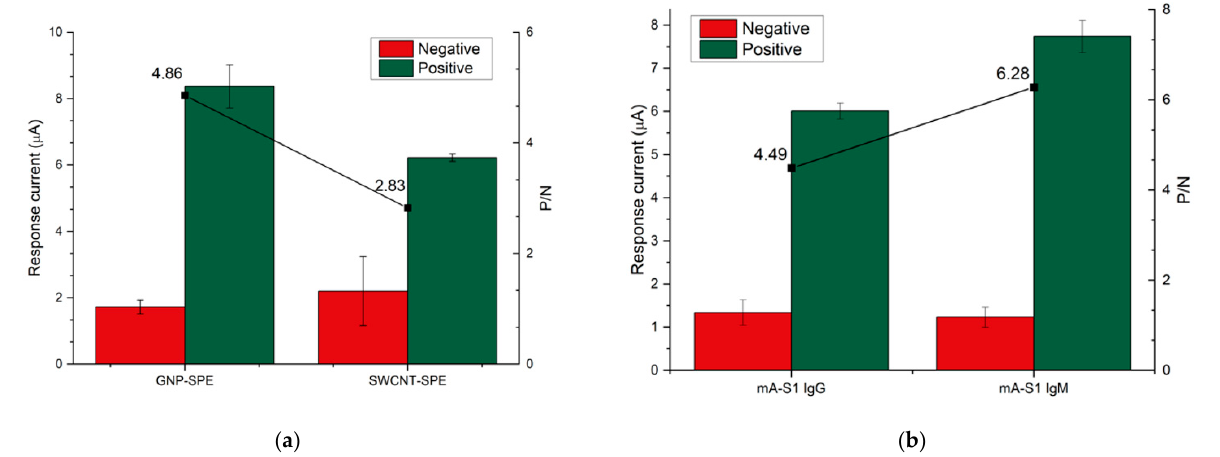
Figure 3. Effect of ( a ) electrode substrate and ( b ) monoclonal capture antibody isotype on the response and P / N ratio of the immunosensor.